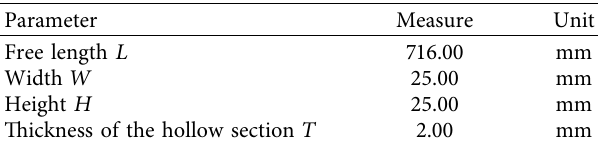
Table 3: The geometry of the box beam.